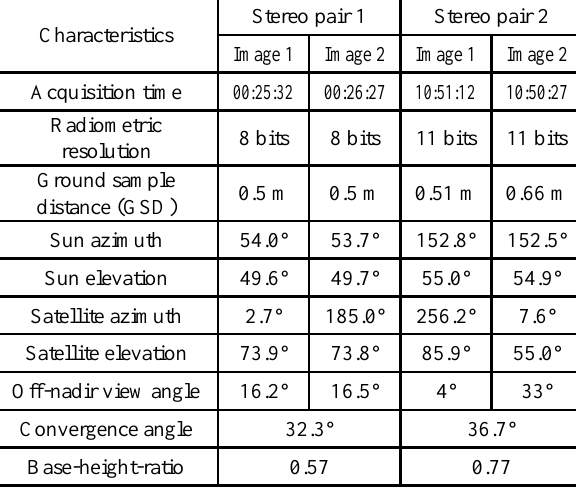
Table 1. Characteristics of two stereo